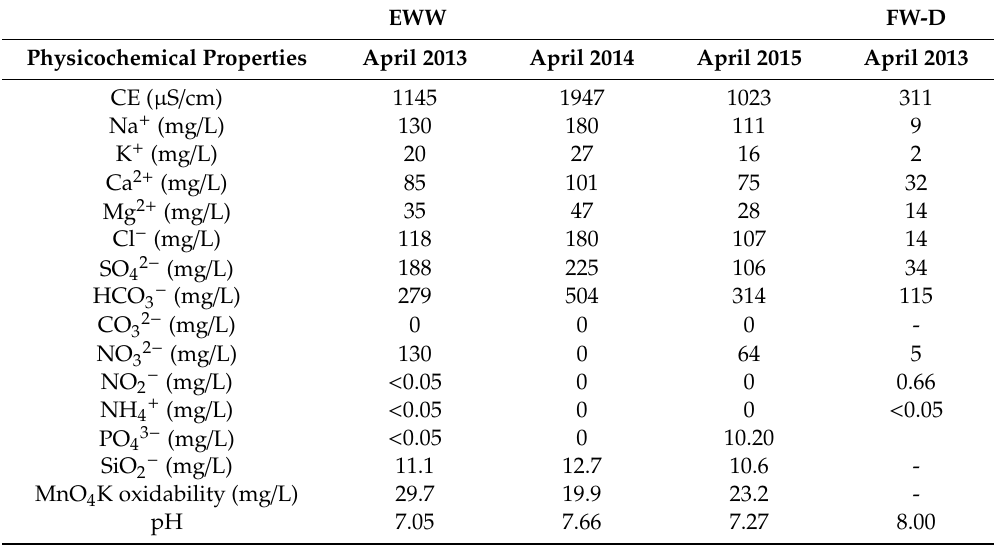
Table 2. Analysis of EWW samples in April 2013, 2014, and 2015, and of FW-D in April 2013. Main physicochemical